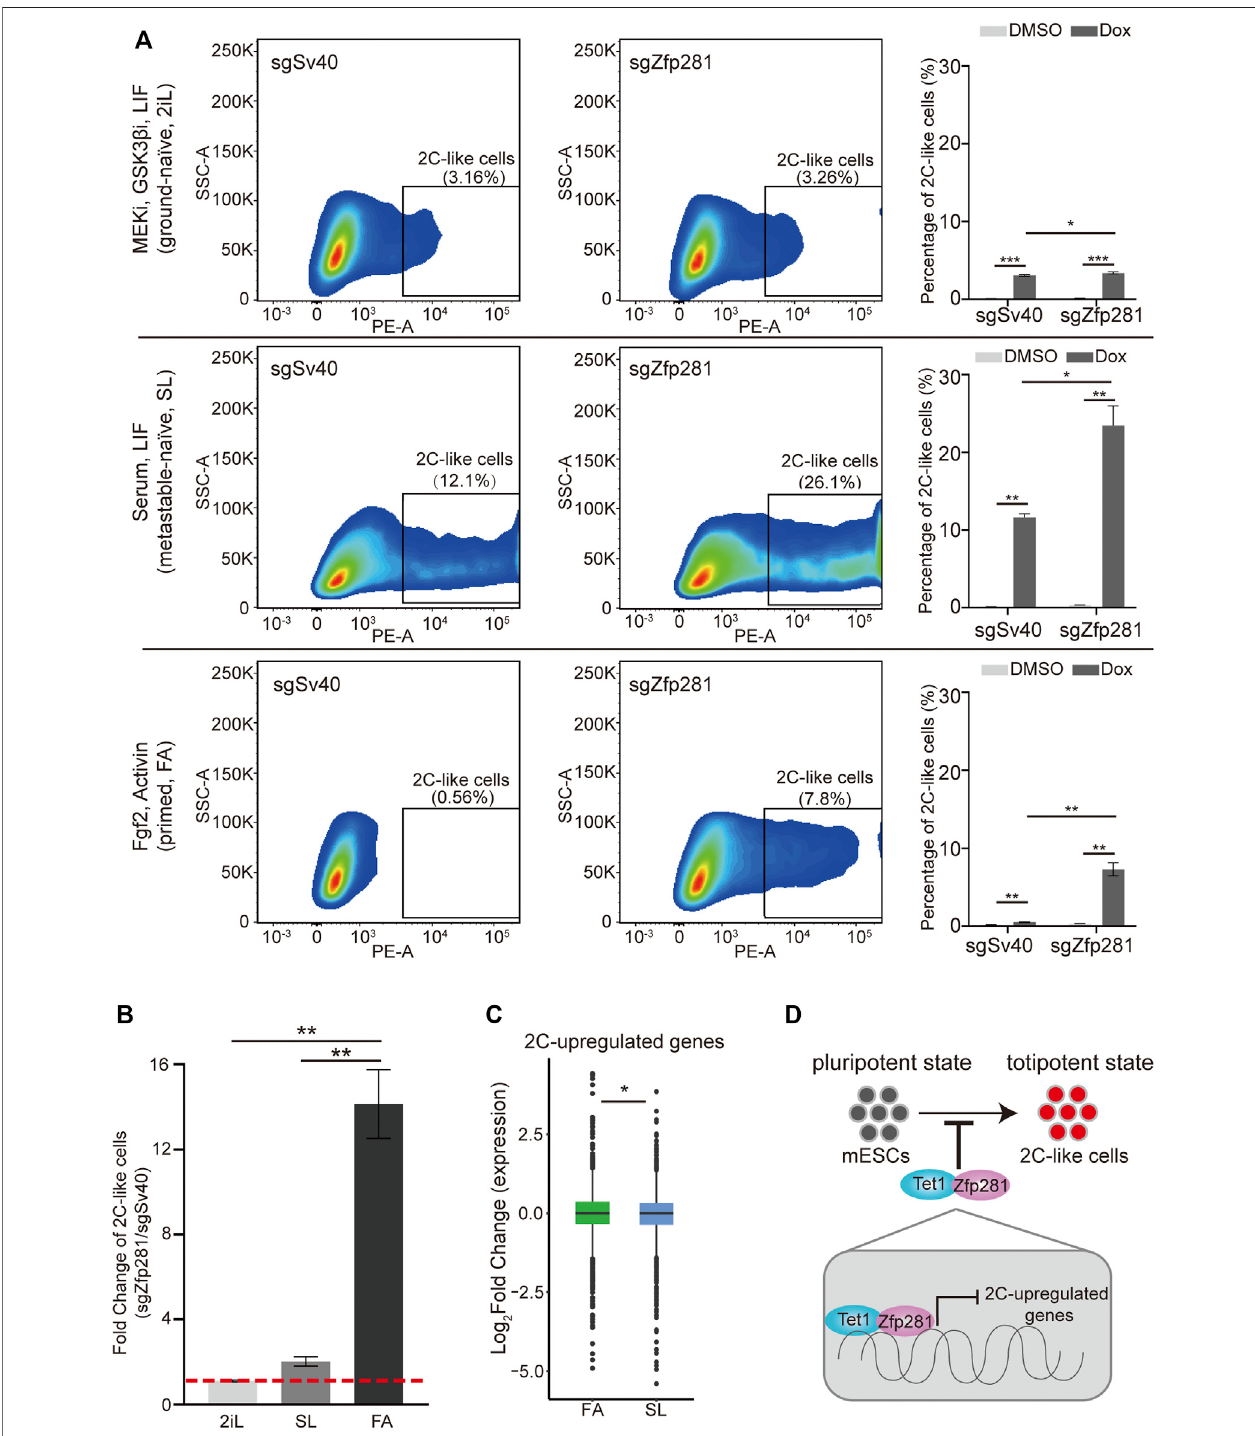
FIGURE 4 | Zfp281 leads to an impaired 2C-like-transition ability in primed-state mESCs. (A) The percentage of 2C-like cell population in ground-naïve (2iL), metastable-naïve (SL), and primed states (FA) mESCs upon indicated perturbation. Representative FACS results are shown. (B) The fold change of the 2C-like cell populationinthree pluripotent states Zfp281-perturbedmESCsnormalized tocontrolmESCs. Redlineindicatesfold changeof1. (A – B) Shown are mean±s.d, n =3. p Values were calculated by unpaired t-test, two-tailed, two-sample unequal variance, * < 0.05, ** < 0.01, *** < 0.0001. (C) A box plot demonstrating the log 2 (fold change) of 2C-upregulated genes expression in metastable-naïve and primed states mESCs upon Zfp281 perturbation. The original RNA-seq was downloaded from GSE81045. p Values were calculated by the Wilcoxon rank-sum test, * < 0.05. The dots represent outliers. (D) A model showing Zfp281 and Tet1 contributes to the impaired 2C-like-transition ability by repressing the expression of2C-upregulated genes. (A – C) Dox represents doxycycline. The X in sgX refers to the gene that sgRNA targets to; sgSv40 is negative control.